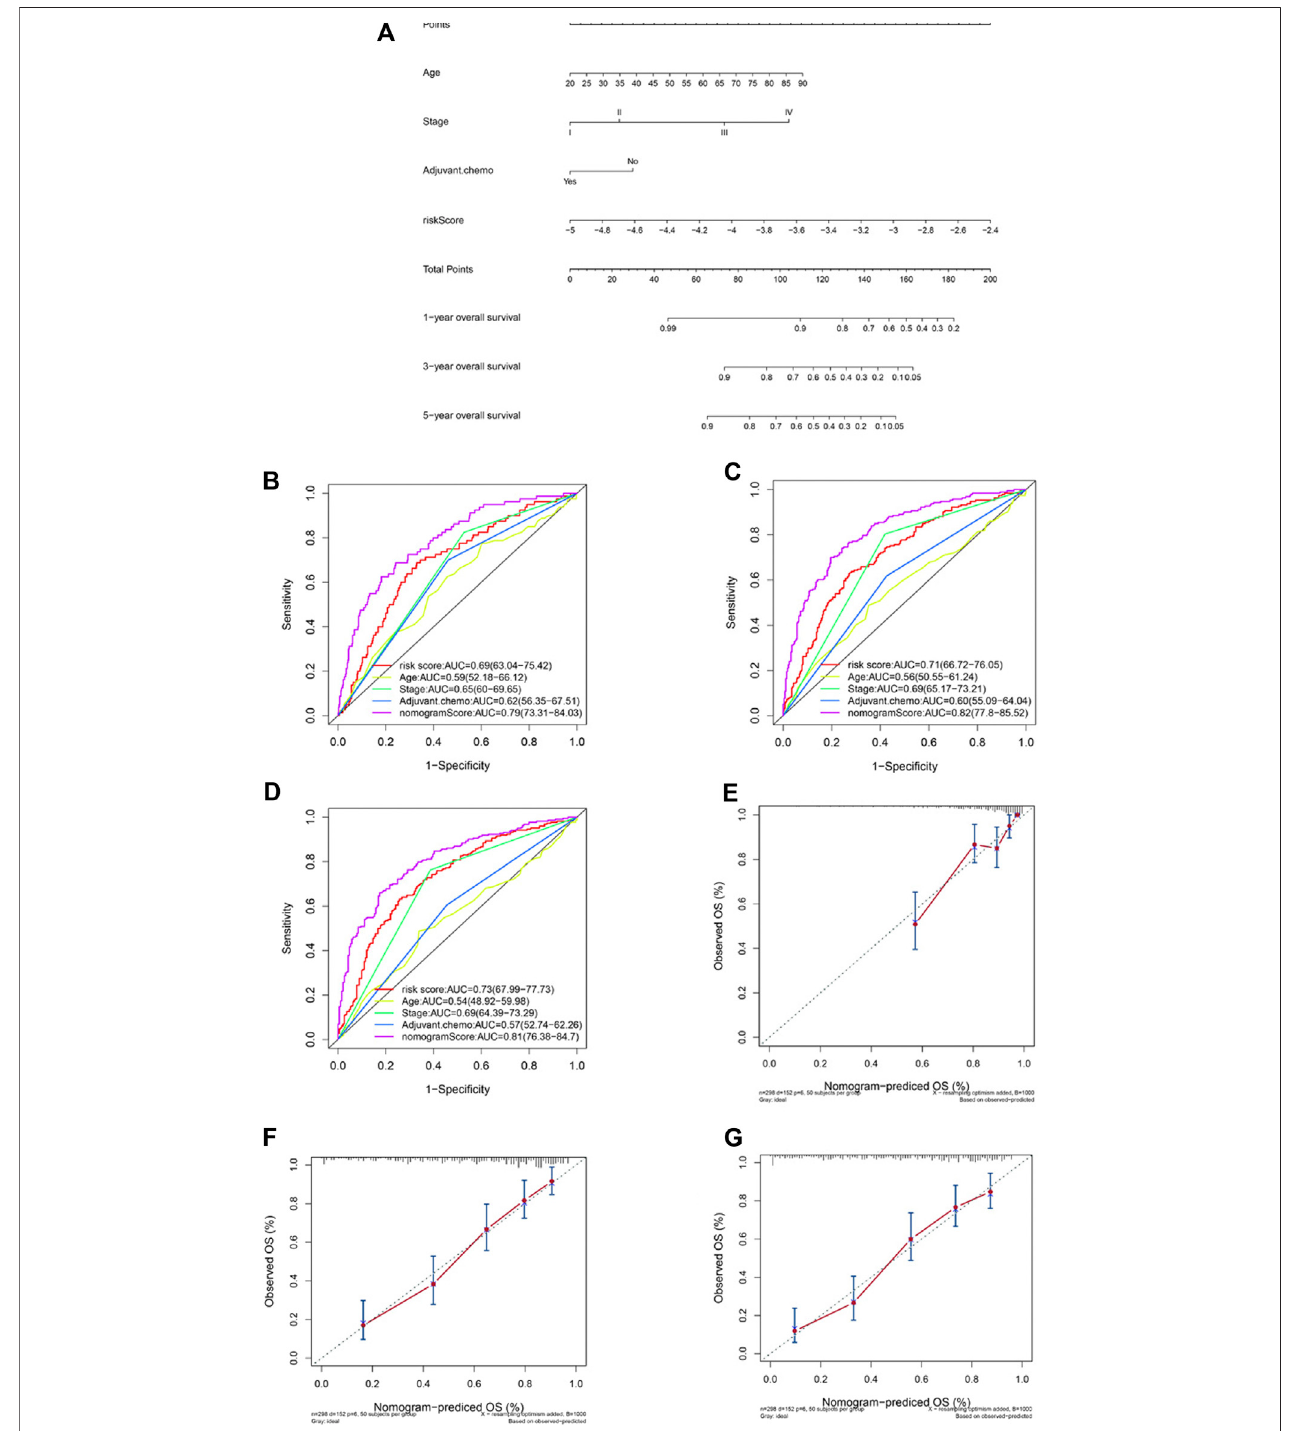
FIGURE 4 | Construction of a nomogram based on the risk predictive score and other prognostic factors. Nomogram constructed based on the risk score and threeotherfactors (A) .ROCanalysiscomparingtheAUCsatsurvivalof1 year (B) ,3 years (C), and5 years (D) amongthenomogram,riskscoremodel,age,stage,and adjuvant chemotherapy. Comparisons between the predicted overall survival of 1-year (E) , 3-year (F) , and 5-year (G) nomogram models and the ideal model.